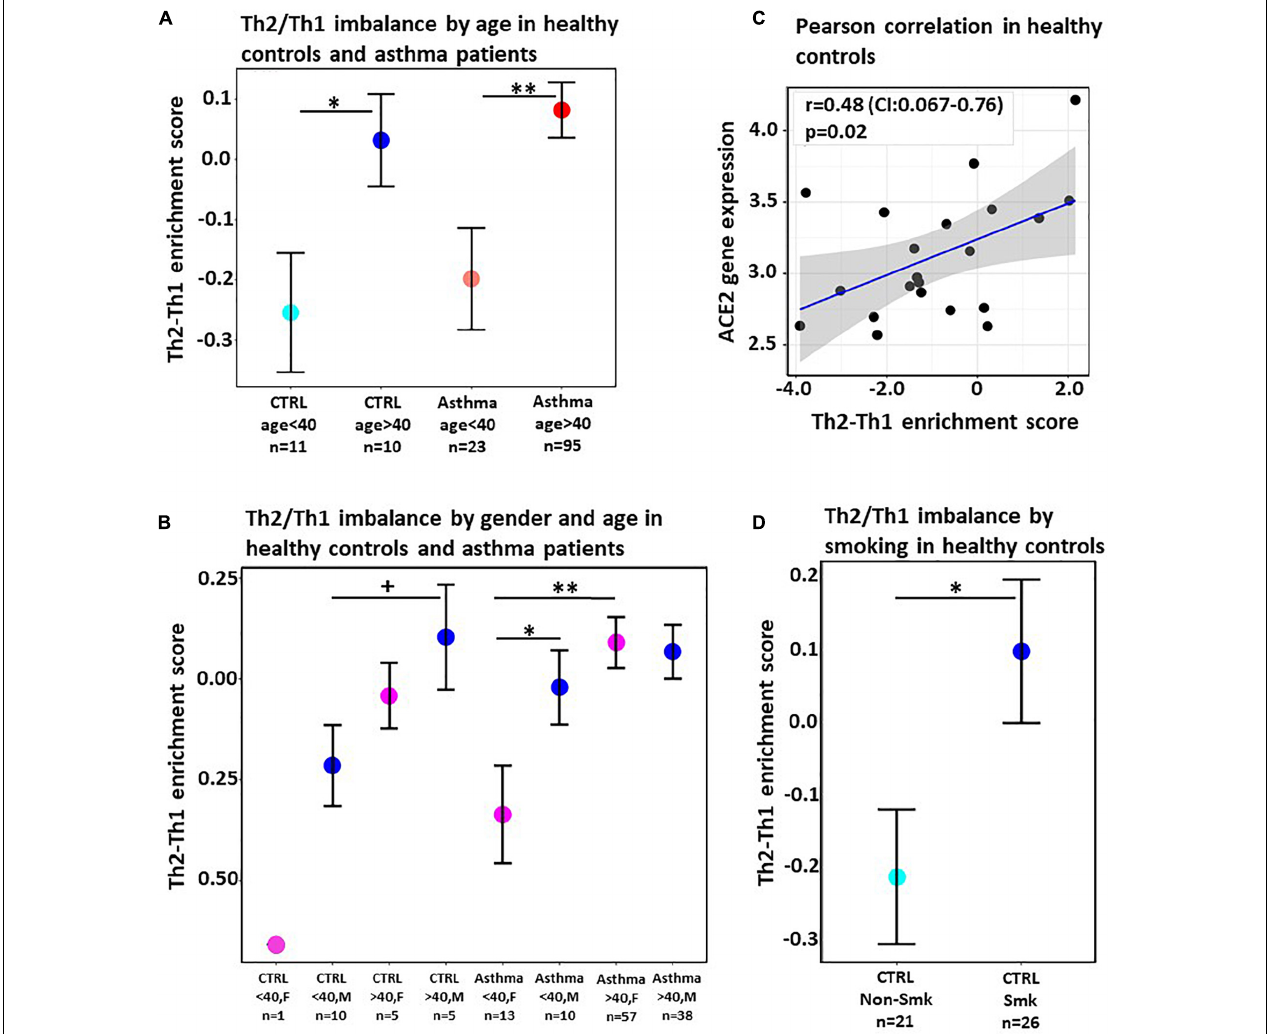
FIGURE 1 | (A) Mean difference in Th2 and Th1 enrichment scores in the sputum of healthy individuals (CTRL) and severe asthma patients stratified by age. Horizontal bars denote standard error. (B) Mean difference in Th2 and Th1 enrichment scores in sputum of healthy individuals (CTRL) and of asthma patients in both males (M) and females (F) stratified by age. Horizontal bars denote standard error. (C) Correlation scatterplot between Th2/Th1 enrichment score and ACE2 gene expression in healthy individuals. Gray shaded area denotes the 95% confidence interval. Pearson correlation coefficient and p -value are provided. (D) Mean difference in Th2 and Th1 enrichment scores in nasal epithelium of healthy smokers and healthy never smokers. Horizontal bars denote standard error. + p < 0.1, * p < 0.05, ** p <